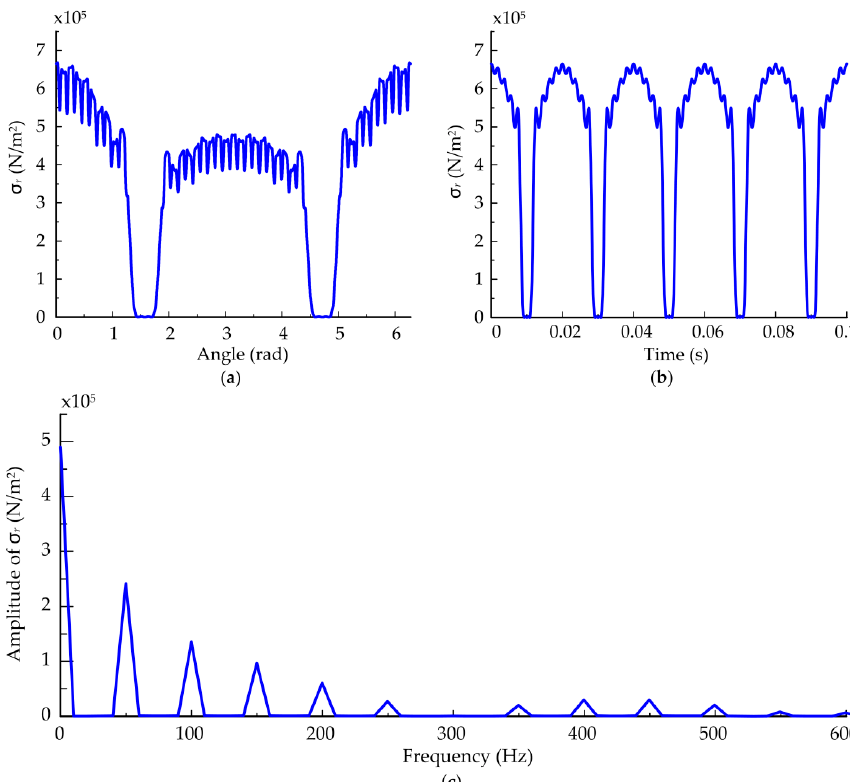
Figure 4. Distribution and spectrum of the radial Maxwell stress. ( a ) Stress distribution at a given time; ( b ) Stress distribution at a given point in time history; ( c ) Spectral characteristics of the stress.